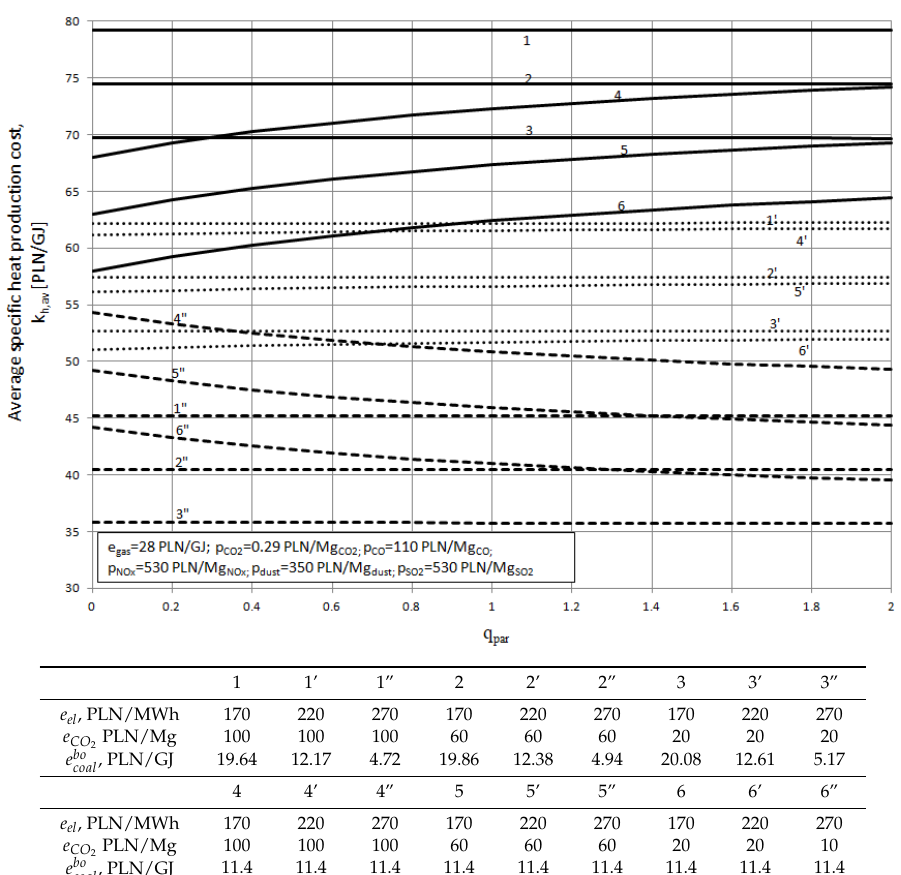
Figure 5. Mean specific cost of heat production as a function of q par with the price of the purchase of CO 2 emission allowances e CO as a 2